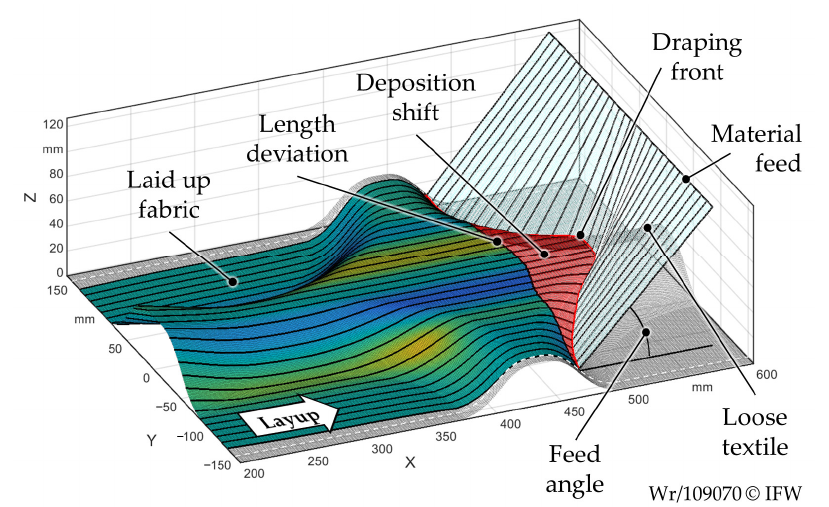
Figure 5. Deposition area on the stiffener with the shift of the draping front to maintain even fiber tension during fabric layup. tension during fabric